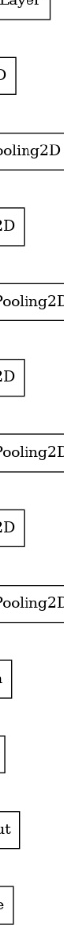
Figure 6. The DCNN model’s architecture.